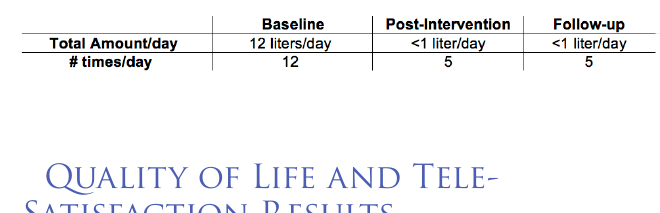
Table 4. Aerophagia Levels (Average Liters/Day Suctioned